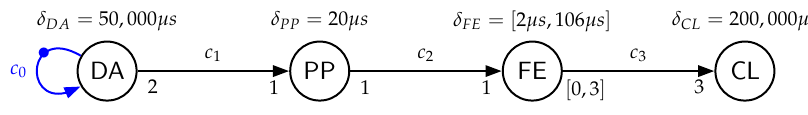
Figure 5. Example CSDF, including mapping and scheduling.